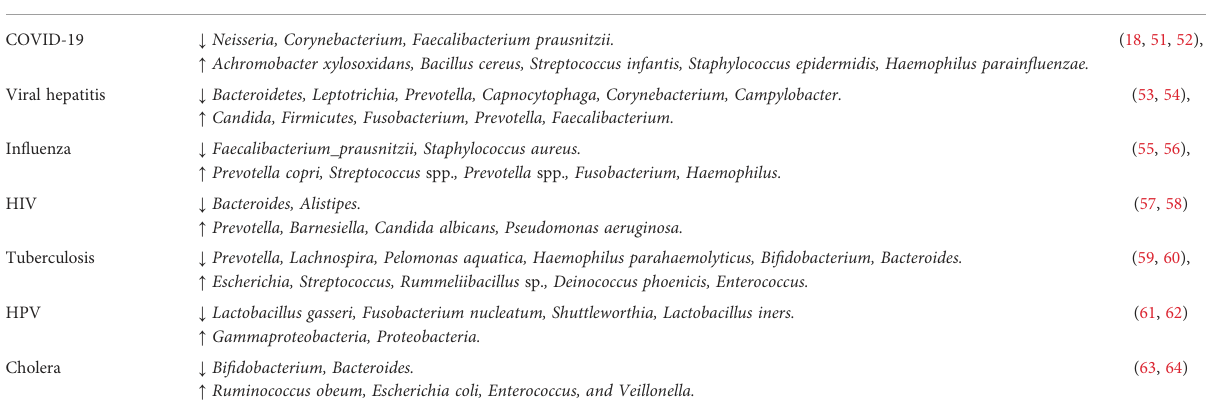
TABLE 1 Microbiota associated with various infectious diseases. Infectious